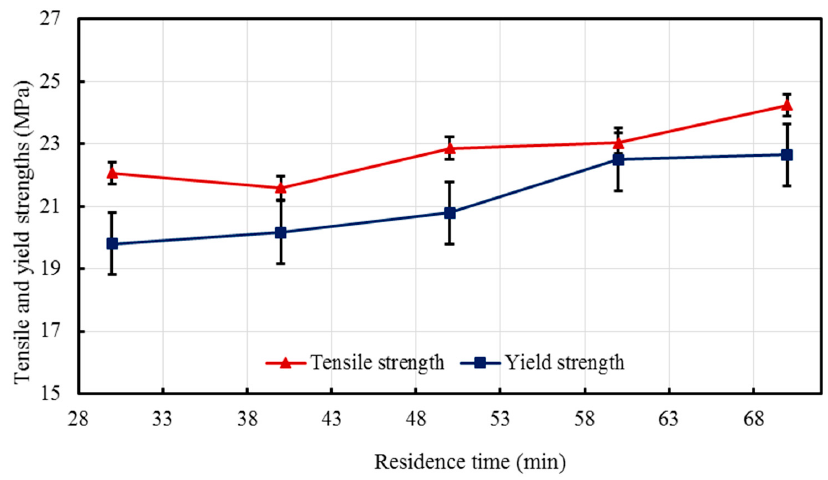
Figure 13. Effect of residence time on yield and tensile strengths of the developed HDPE-TiO 2 nanocomposites (SE bars included).